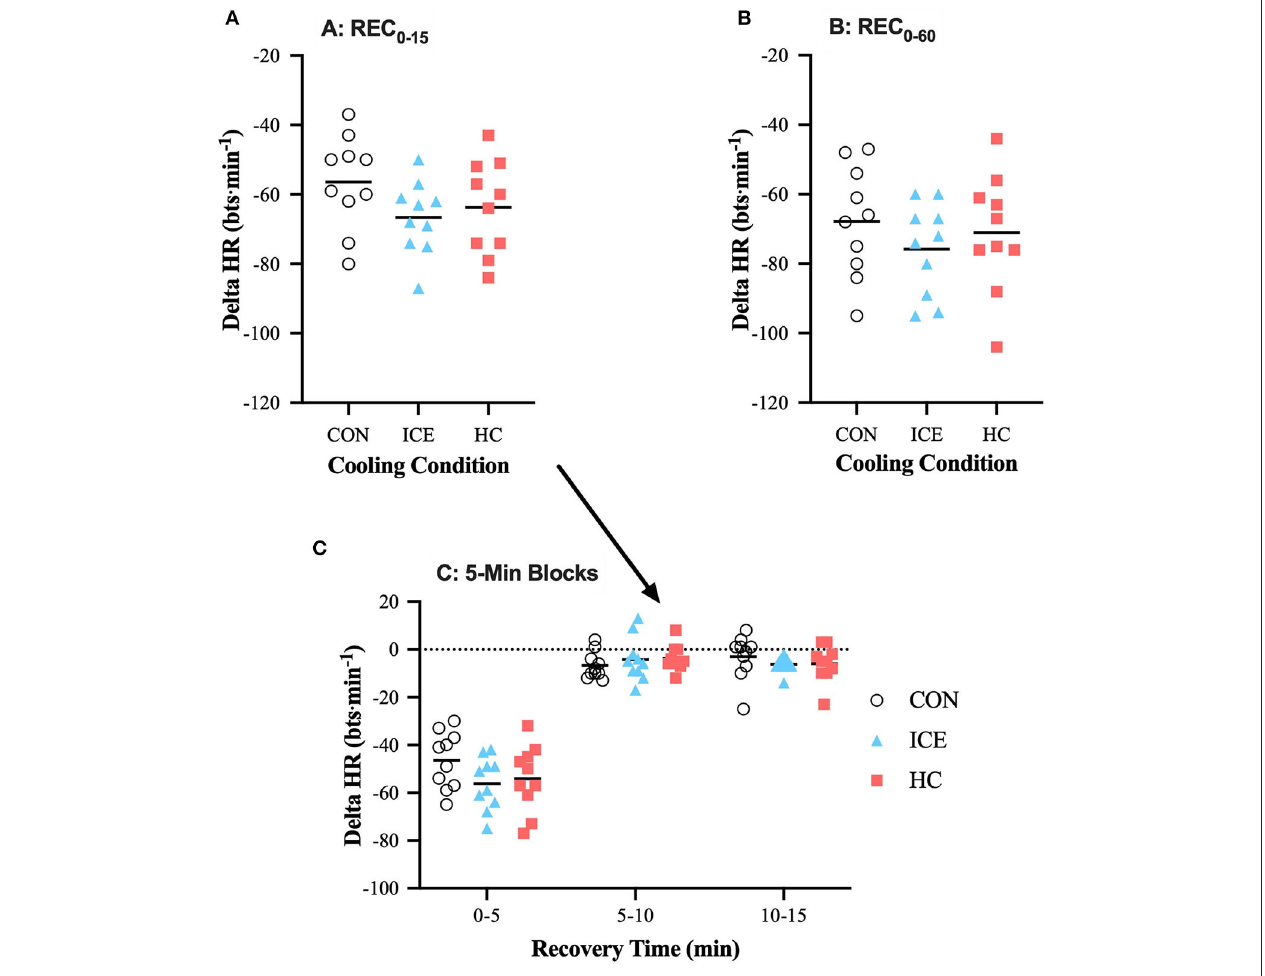
FIGURE 5 | Mean (bar) and individual delta heart rate (HR) during REC 0 − 15 (A) , REC 0 − 60 (B) , and 5-min blocks during REC 0 − 15 (C) when using ice vest (ICE), single-hand cooling (HC), and non-cooled control (CON) during heated exercise recovery.